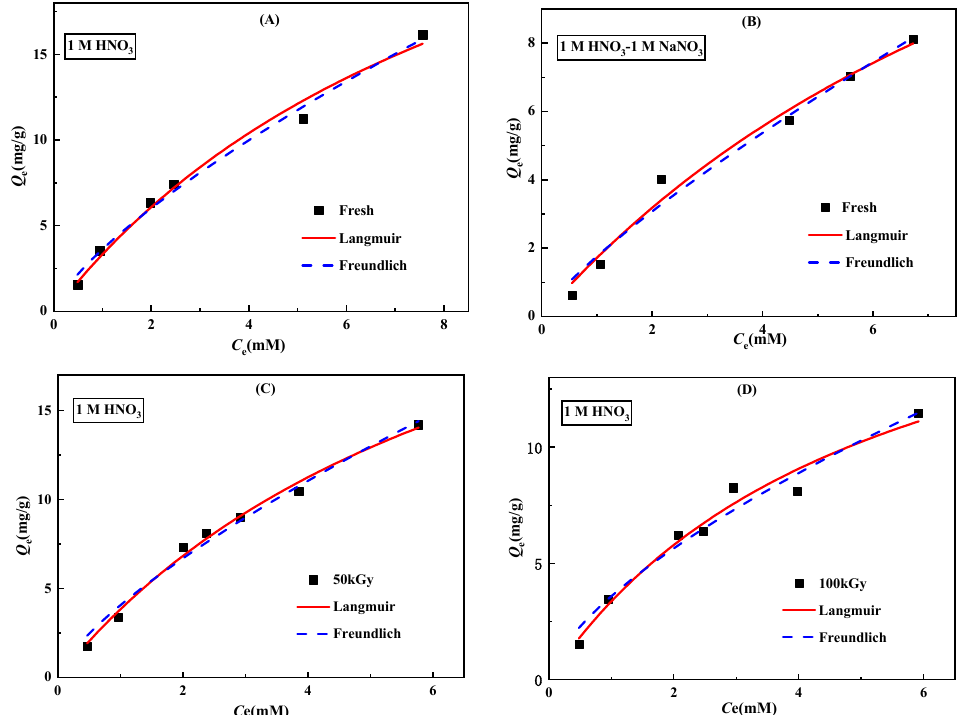
Figure 8. The adsorption isotherms of ( A ) the fresh N3/SiO 2 in 1 M HNO 3 , ( B ) the fresh N3/SiO 2 in a mixture of 1 M HNO 3 and 1 M NaNO 3 , ( C ) the irradiated N3/SiO 2 (50 kGy) in 1 M HNO 3 , and ( D ) the irradiated N3/SiO 2 (100 kGy) in 1 M HNO 3 , with the following adsorption conditions: V / m = 100 cm 3 /g, T = 25°C, and contact time = 12 h. Table 2. The estimated isotherm parameters of the adsorption isotherms. Models